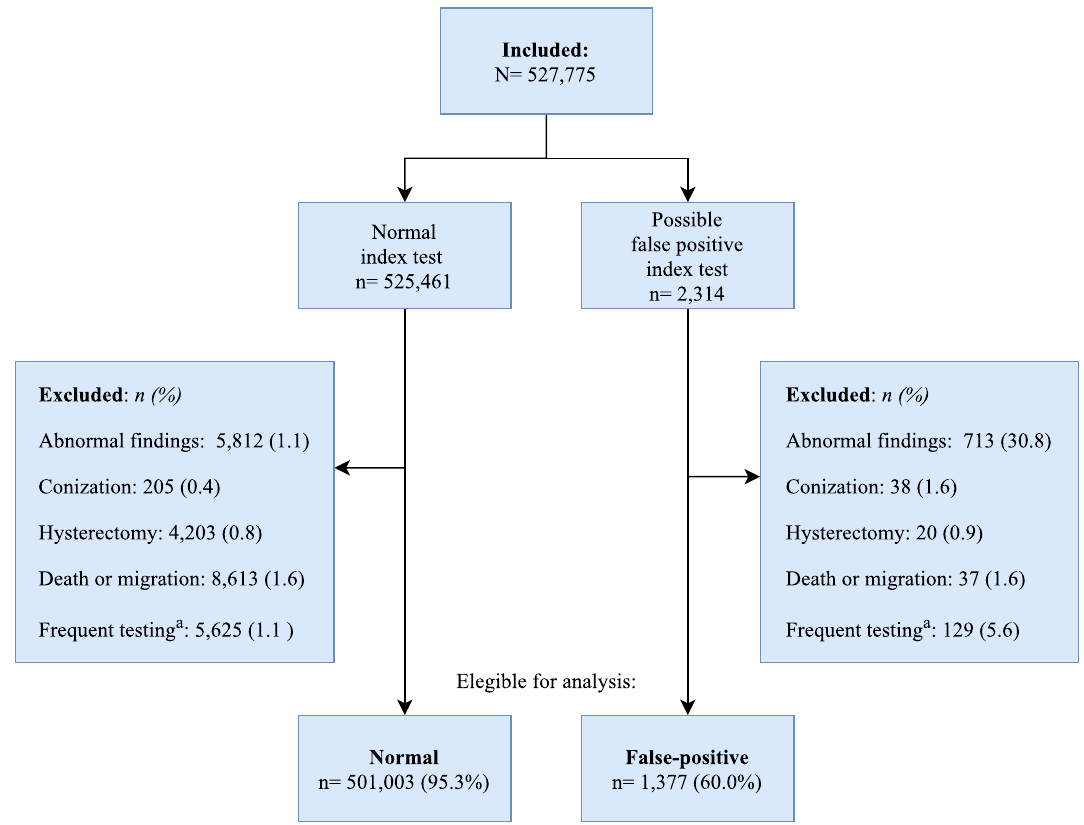
Figure 2. Flowchart of inclusion and exclusion. a Women who never have 24 months in between tests during follow-up despite of no abnormal